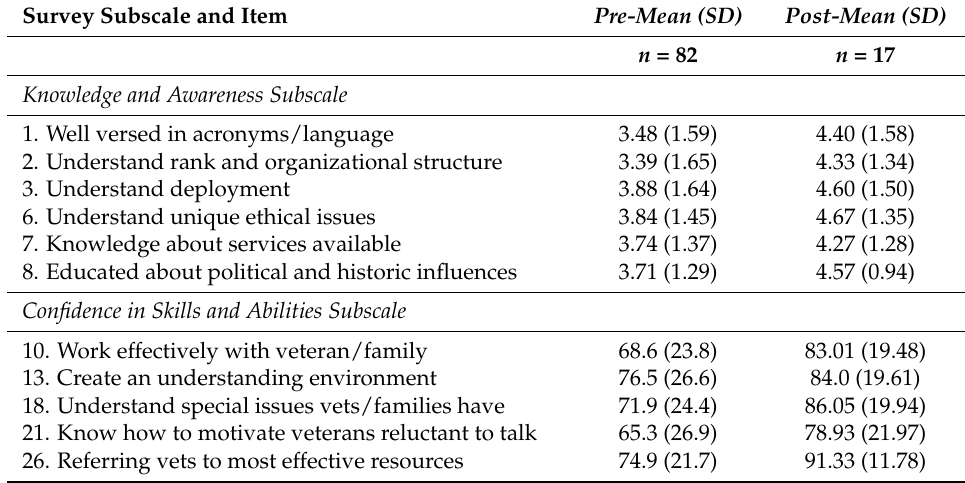
Table 3. Survey items not meeting pre-determined benchmarks at